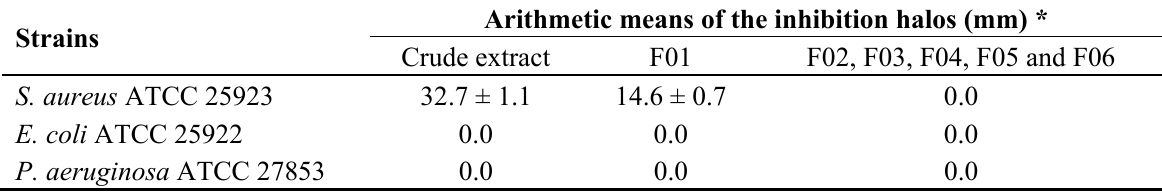
Table 5. Inhibition halos (mm) resulting from tests of vapor diffusion in agar.